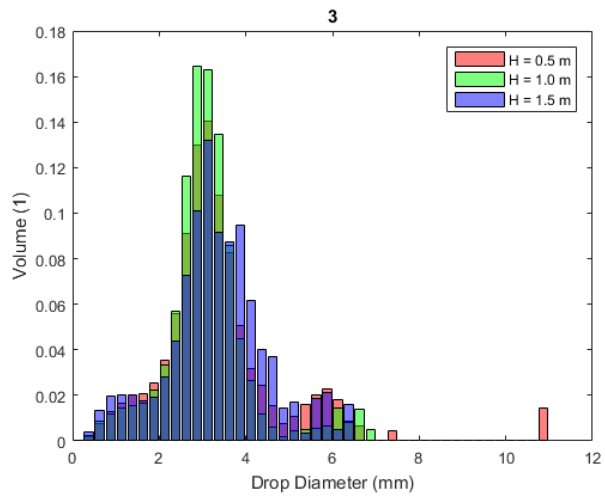
Fig. 11. Drop size histogram based on volume for the mean water flow rate 0.0001517 m 3